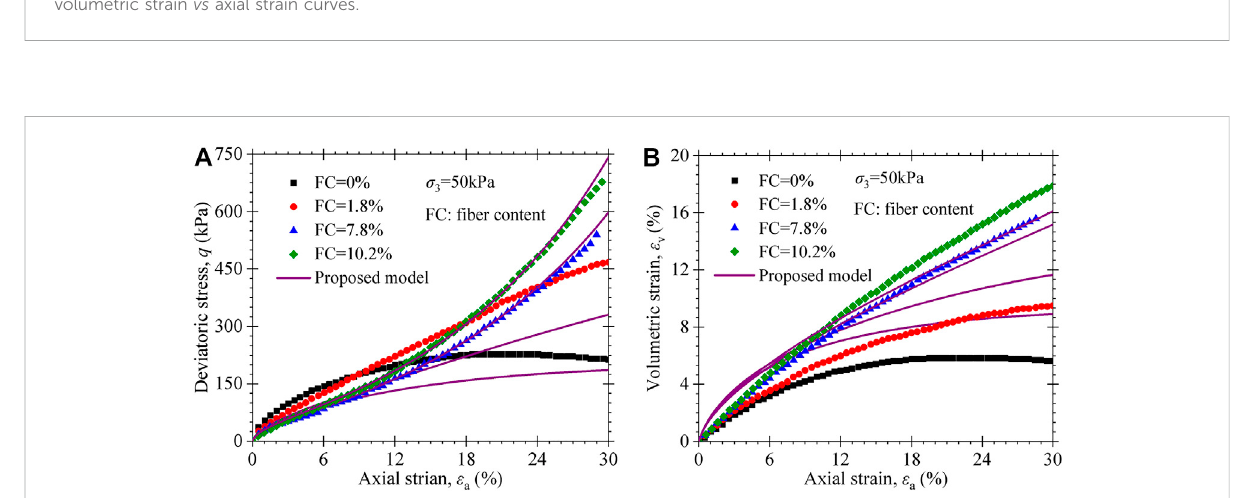
Experimentaland predicted triaxialtestresults of MSWspecimenswith different fi brous content atacon fi ningpressure of50kPa from Ramaiah and Ramana (2017): (A) stress – strain curves; (B) volumetric strain vs. axial strain